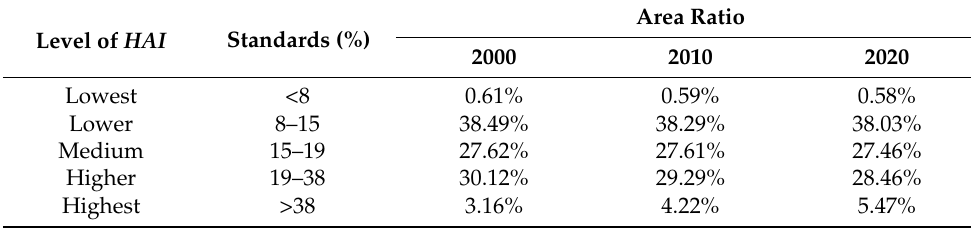
Table 5. Human activity intensity at different times.